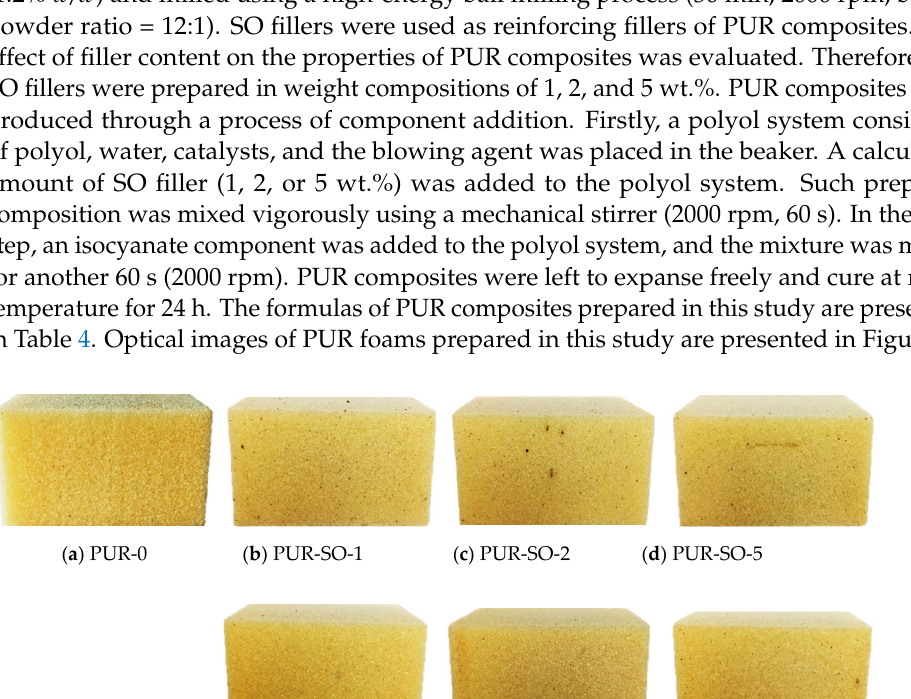
Table 4. Chemical formulas of PUR composites prepared in the following study.